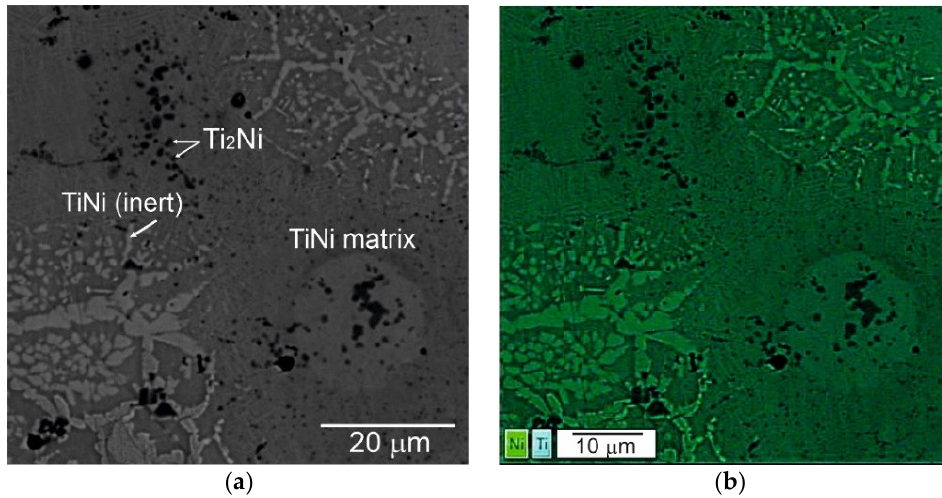
Figure 4. SEM image ( a ) and EDS elemental mapping ( b ) of initial porous TiNi alloy. Table 2. Elemental composition of phases in TiNi SHS alloys. Identification Ti, at.% Ni, at.% O, at.%